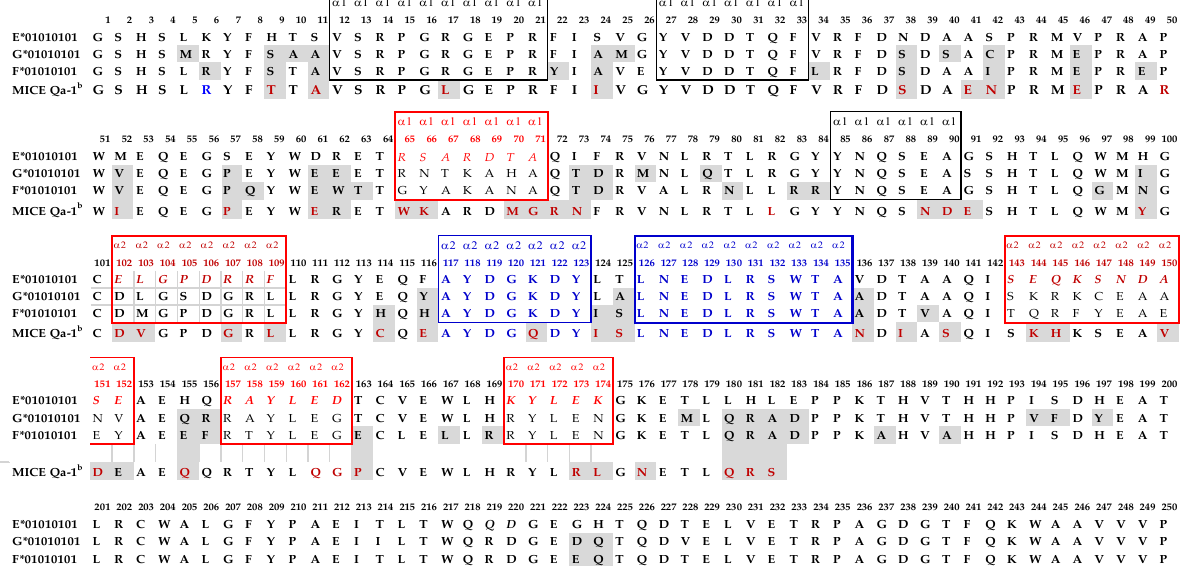
Figure 1. Comparative profile of the amino acid sequences of HLA-E, HLA-G, and HLA-F, and a partial profile of the sequences of mice equivalent of HLA-E, known as Qa1 b . The amino acid sequences of HLA-E are compared with the amino acid sequences of HLA-G and HLA-F, and also with 504 HLA-A, 844 HLA-B, and 283 HLA-C alleles, to determine the HLA-E specific sequences. The HLA-E specific sequences in α 1 and α 2 helical domains are shown within the red boxes. HLA-Ib shared epitopes area are shown in black and blue boxes. Sequences in the blue boxes are shared with all HLA-Ia isoforms, while those in black boxes are shared with most, if not all, HLA-Ia alleles. To further confirm the monospecificity, we carried out dosimetric inhibition of purified HLA-E SPECIFIC culture supernatants of TFL-033 with two HLA-E-restricted peptides, 65 RSARDTA 71 and 143 SEQKSNDASE 152 , at concentrations ranging from 4.4 to 0.27 mg/well. Although both peptides showed inhibition, the α 2 helical peptide SEQKSNDASE showed better dosimetric inhibition than the other peptide [37]. Figure 3 illustrates the conformational orientation of the HLA-E mAb specific epitopes on the α 1 and α 2 helices of HLA-E. It is important to note that the mAbs do not recognize linear epitopes but recognize conformationally altered epitopes. The yellow letters in the figures represent the exposed amino acids on the epitope, while the amino acids in the white letters represent the masked